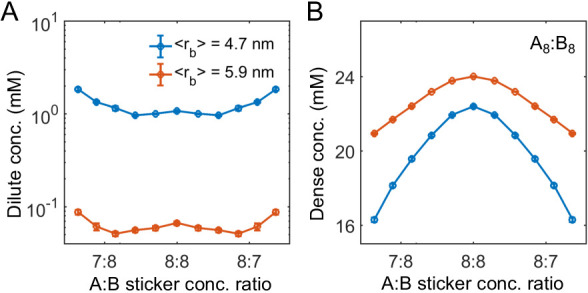
Linker length strongly influences phase boundaries in simulations.Sticker concentrations in (A) dilute and (B) dense phases for A8:B8 system at different global sticker stoichiometries with linkers modeled by a FENE potential (Equation (34)) with K=0.3⁢kB⁢T and R0 = 7 nm (mean linker length 4.7 nm, blue) and K=0.15⁢kB⁢T and R0 = 14 nm (mean linker length 5.9 nm, red). Parameters: repulsive interaction strength ϵ=1⁢kB⁢T and length scale σ = 3 nm, specific interaction strength U0=12⁢kB⁢T with cut-off distance r0 = 1.5 nm, and total global sticker concentration 6.64 mM.